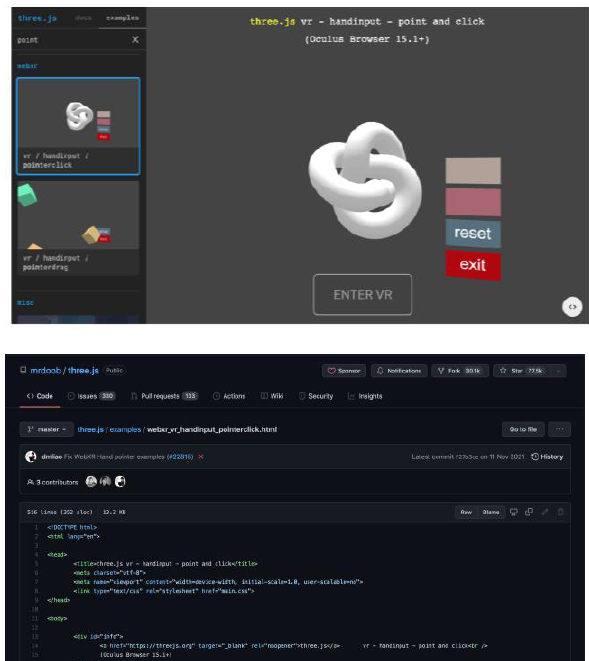
Figure 7. Display of 3d objects in Three.js (top) and its available code